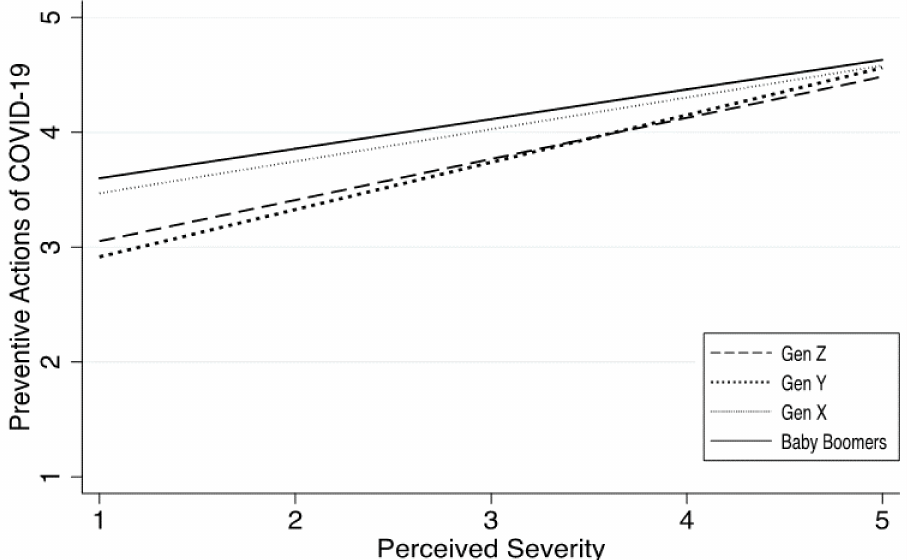
Figure 3. Comparison of preventive actions against COVID-19 by four generations, with 95% CI. Note: preventive action is measured as an average of six items on a 5-point scale, with bigger values indicating that more preventive actions would be taken by respondents (see details in Table